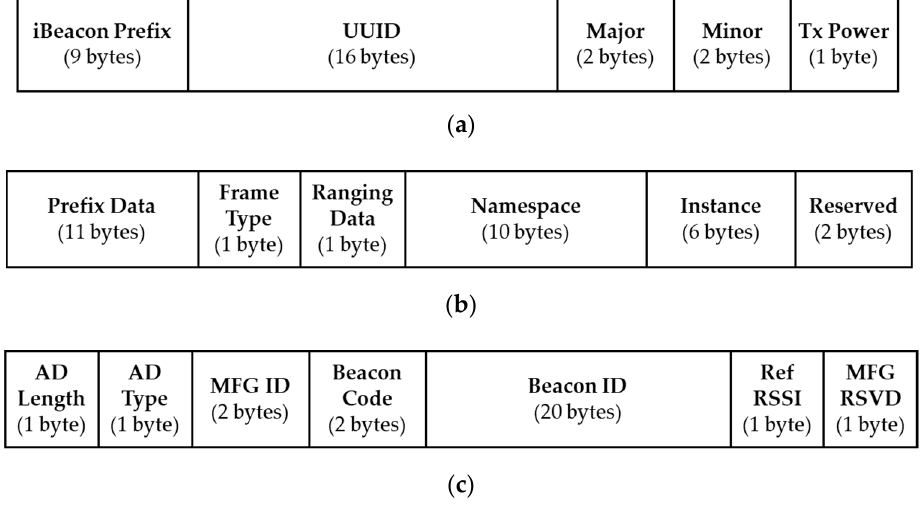
Figure 1. Packet formats of three Bluetooth beacon pseudo-standards: ( a ) iBeacon, ( b ) Eddystone-UID, and ( c ) AltBeacon.